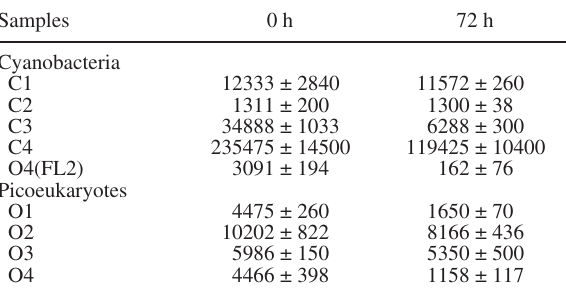
Table 2. – Initial and final cell densities (cell mL -1 ) for the stud- ied populations of cyanobacteria (C1, C2, C3, C4, O4(FL2)) and picoeukaryotes at the maximum copper concentration toxic